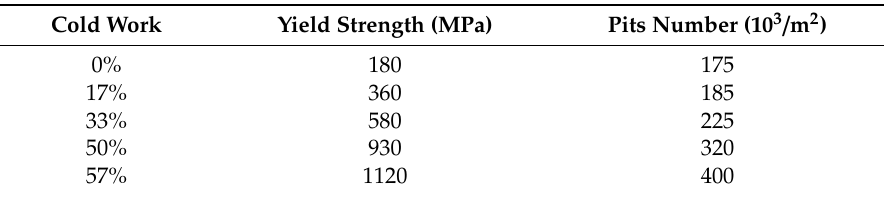
Table 4. Yield strength and number of pits per m 2 .